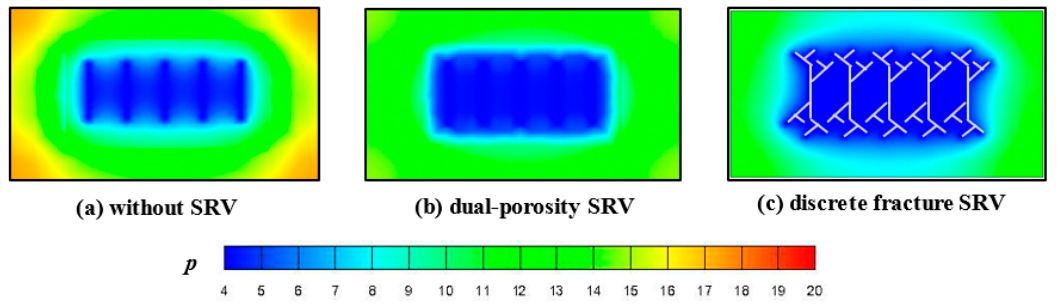
Figure 12. The pressure distributions of different SRV models (3000 days).